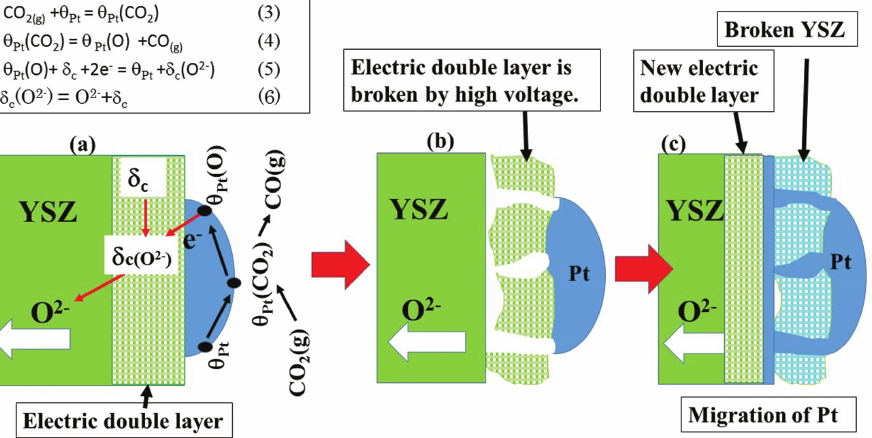
Figure 12: Reaction mechanism of CO 2 electrolysis in cathode and the breakage by high voltage and formation of a new electric double